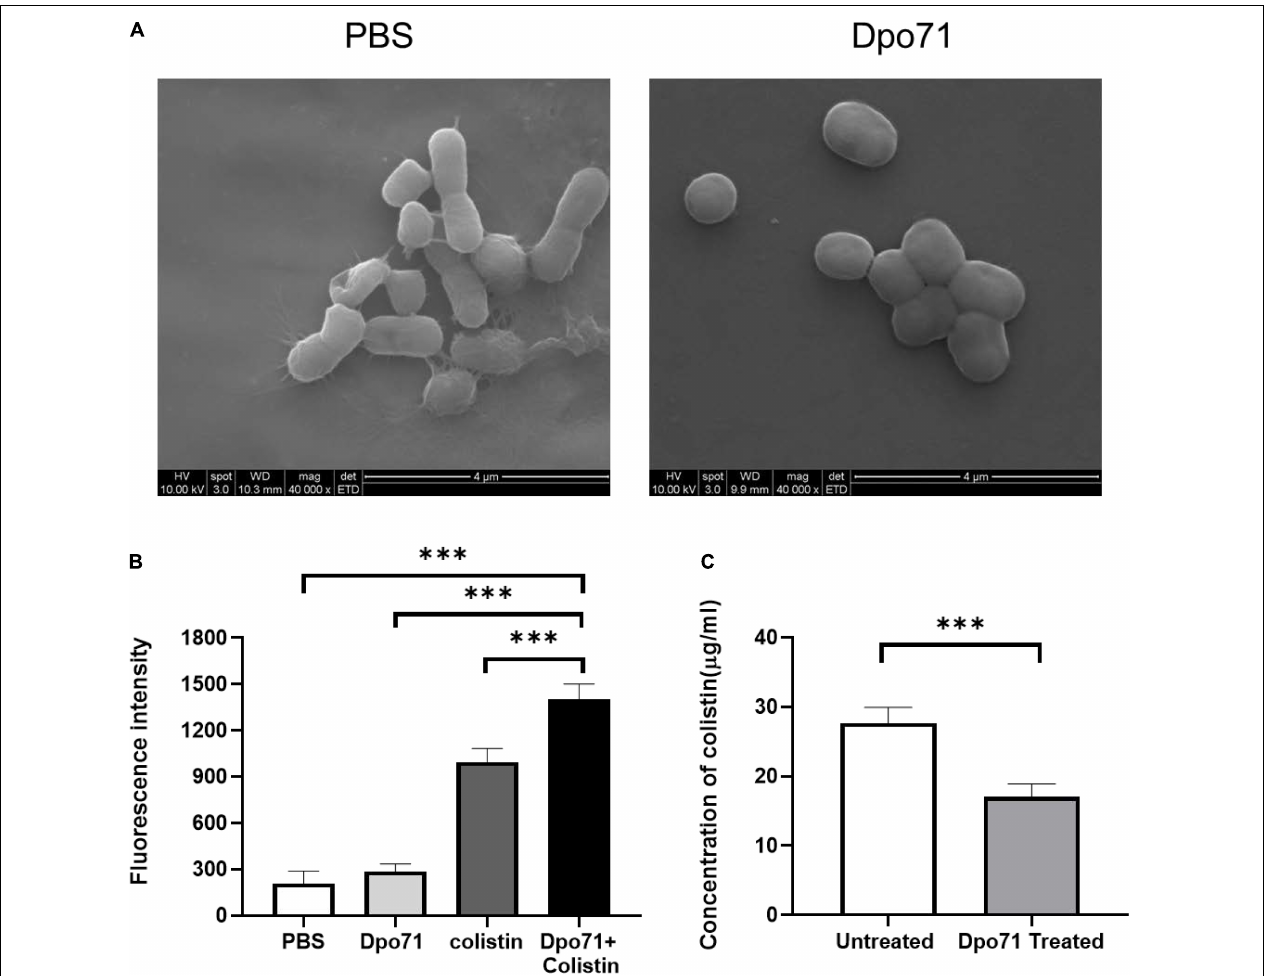
FIGURE 4 | Mechanistic studies using the Dpo71 as an adjuvant agent. (A) Representative Scanning Electron Microscope (SEM) images of A. baumannii incubated with PBS and Dpo71 (10 µ g/ml). Scale bar 4 µ m. (B) NPN uptake assay of A. baumannii induced by PBS buffer; Dpo71; colistin (1 µ g/ml); and their combination agents (Dpo71 + colistin). Net fluorescence signals with the background signal of the cells subtracted are used. Data are expressed as means ± SD ( n = 3) with ∗∗∗ p < 0.001 determined by Student’s t -test. (C) Assessment concentration of the unbounded colistin. A. baumannii were treated with Dpo71 or PBS for 2 h, then after 5 min incubation of the colistin, the cells with the bound colistin were sedimented. The supernatant was centrifuged and the unbound colistin was measured with the HPLC. Data are expressed as means ± SD ( n = 3) with ∗∗∗ p < 0.001 determined by Student’s t